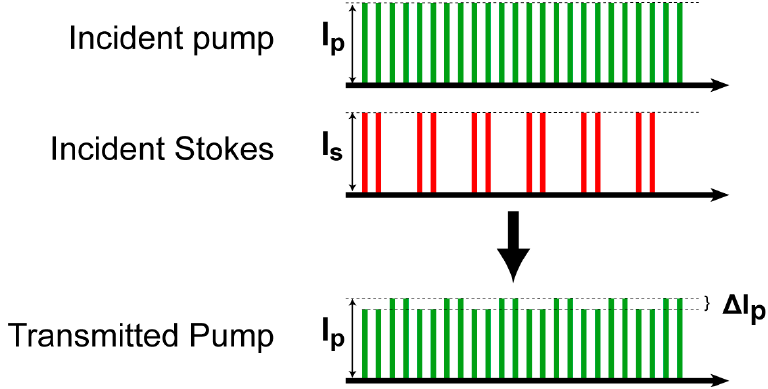
Figure 1. Energy bands in stimulated Raman scattering (SRS).